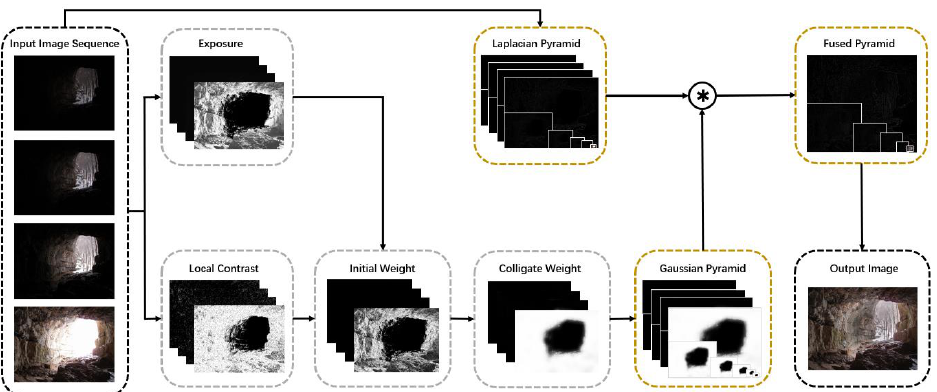
Figure 1. Schematic of the proposed method. The operation process of " ∗ " in the figure is shown in Equation (17). Algorithm 1: The proposed algorithm.